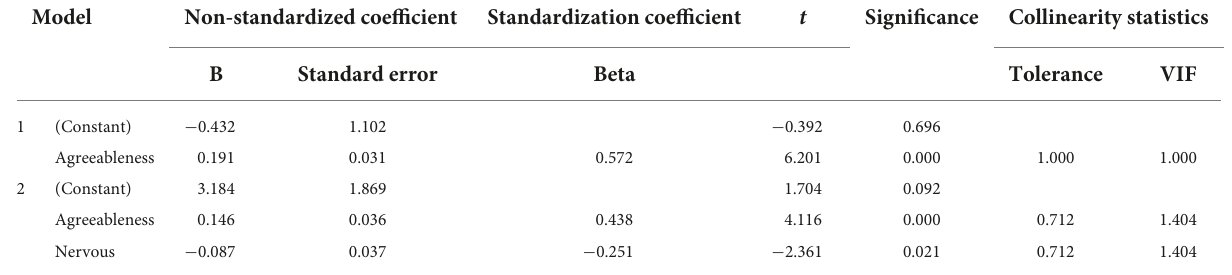
TABLE 3 Significance test results.